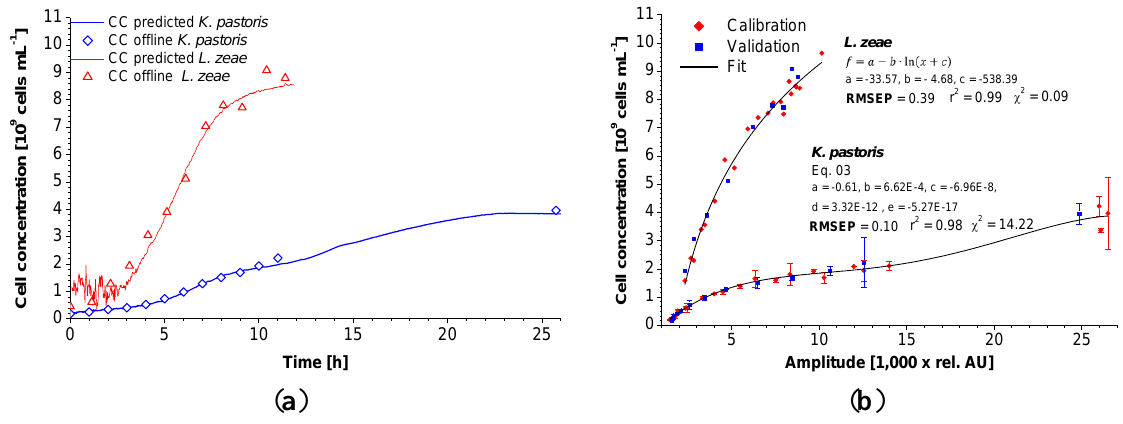
Figure 6. Exemplary dynamic calibration of the biomass sensor signal versus cell concentration for K. pastoris and L. zeae . Red diamonds represent two experiments. Blue squares represent one validation experiment ( a ). Application of the calibration function on the biomass sensor signal of the validation growth curve along with the offline measured data ( b